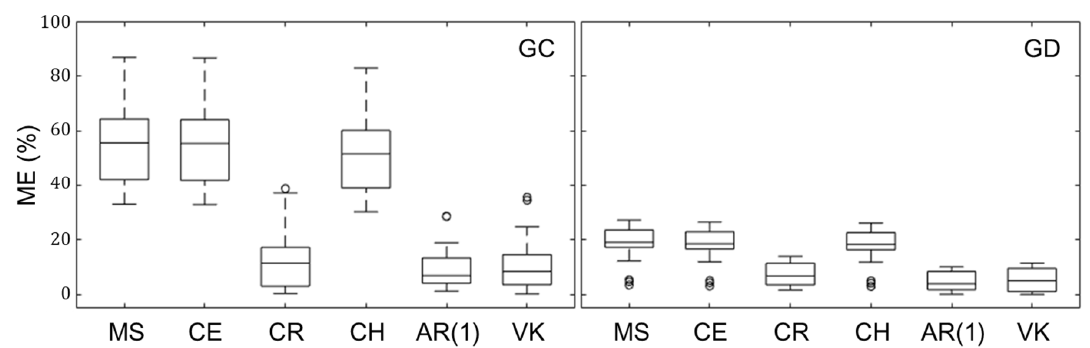
Figure 6. Root mean square error (RMSE) of the six methods in the GC and GD catchments.